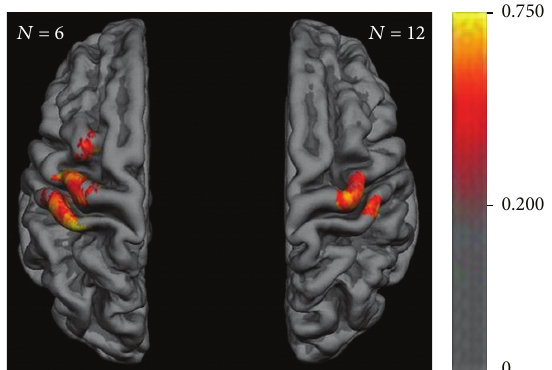
Figure 5: Motor map reliability with intraclass correlation (ICC) for the MEP amplitudes > 50 𝜇 V at each mesh point. Color bar indicates ICC value of repeatability in the course of the six experiments revealing mosaic-likeclustersofconsistentcorticospinal